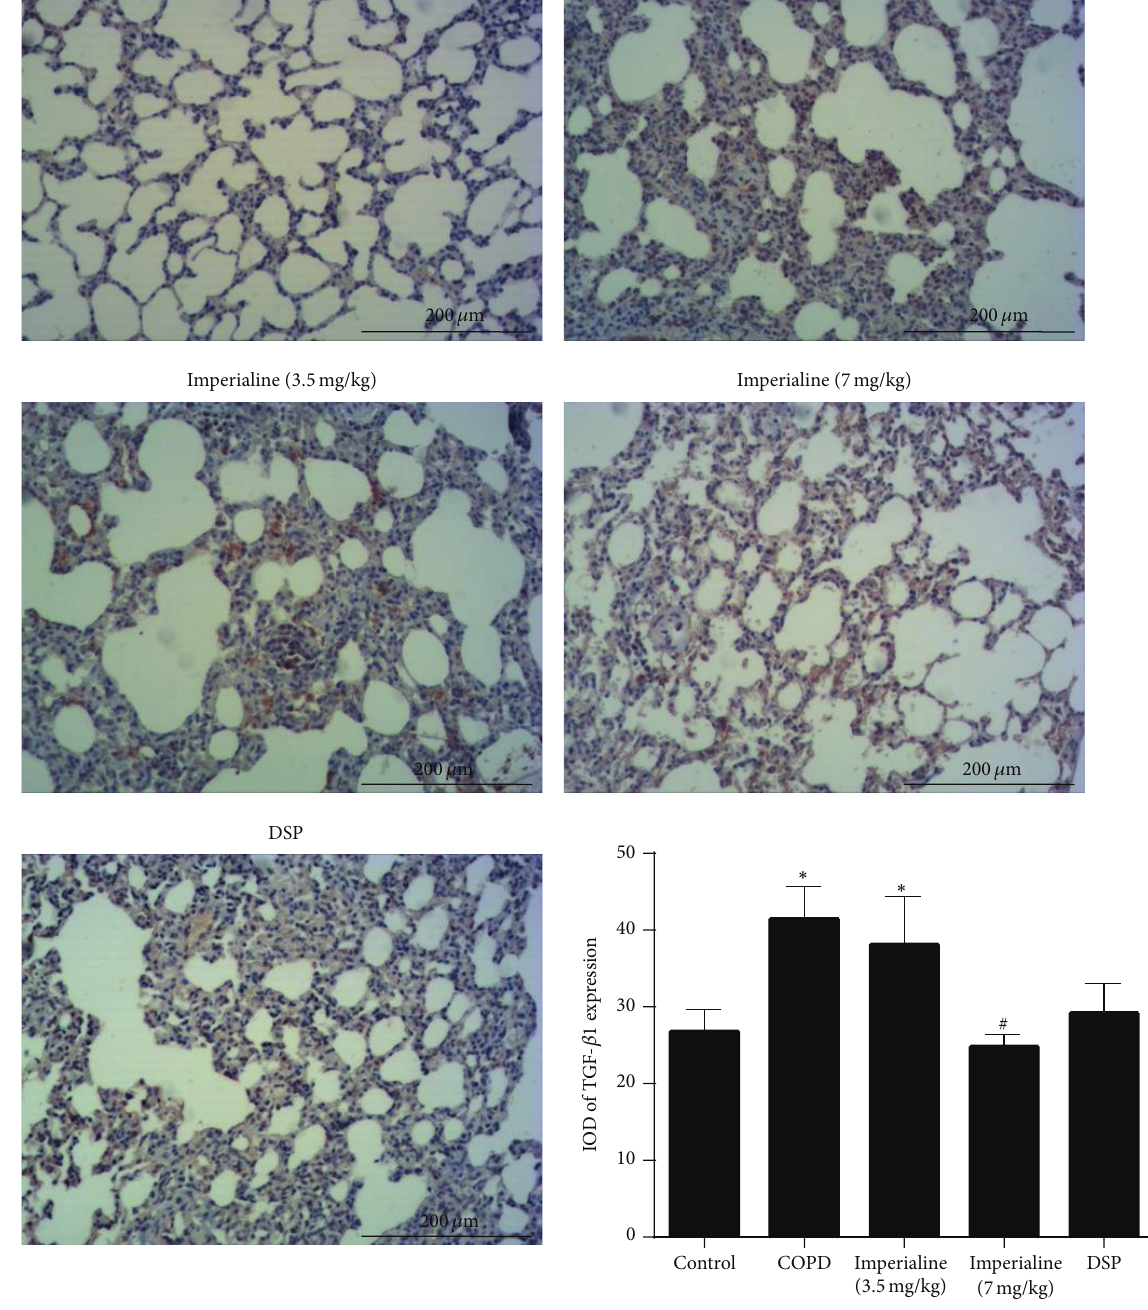
Figure 10: Immunohistochemical staining of TGF- 𝛽 1 in lung tissues of rats in different groups and IOD of TGF- 𝛽 1 expression. Results were expressed as the mean ± SEM ( 𝑛 = 10 ). Significant differences compared with the control group were designated as ∗ 𝑃 < 0.05 . Significant differences compared with the COPD group were designated as # 𝑃 < 0.05